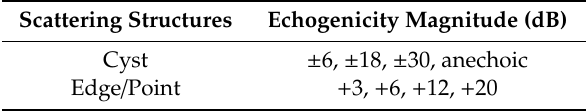
Table 1. Echogenicity magnitudes of the scattering structures.